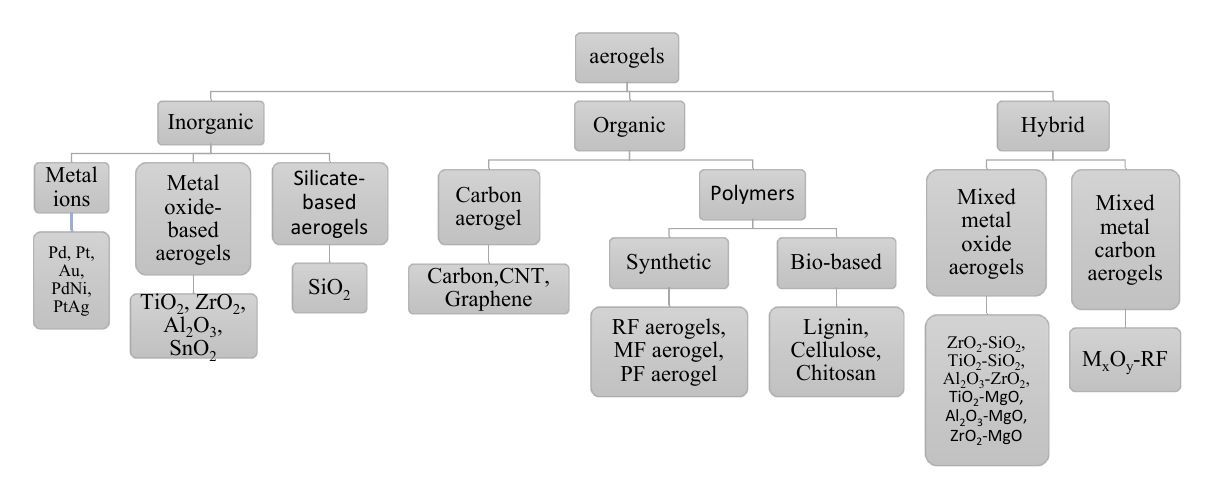
Figure 1. Classification of aerogels.